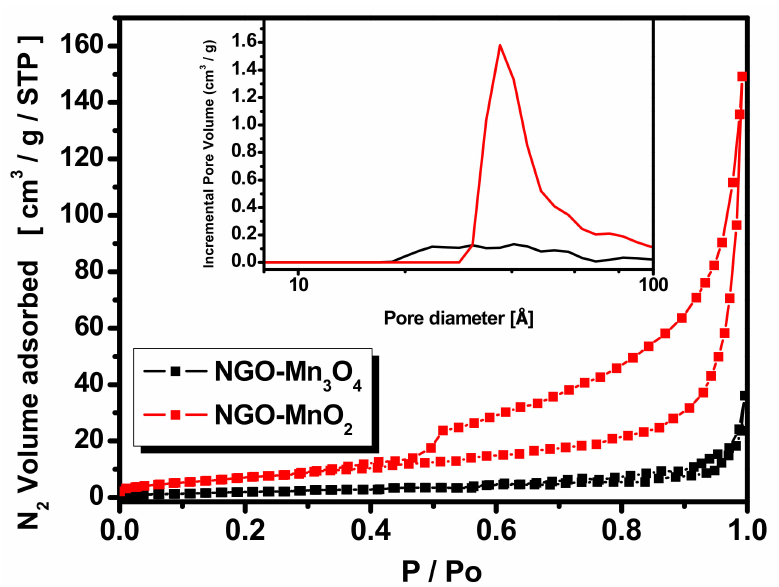
Figure 2. N 2 adsorption isotherms and pore diameter distribution (inset) for NGO–Mn 3 O 4 and NGO–MnO 2 modified composites.